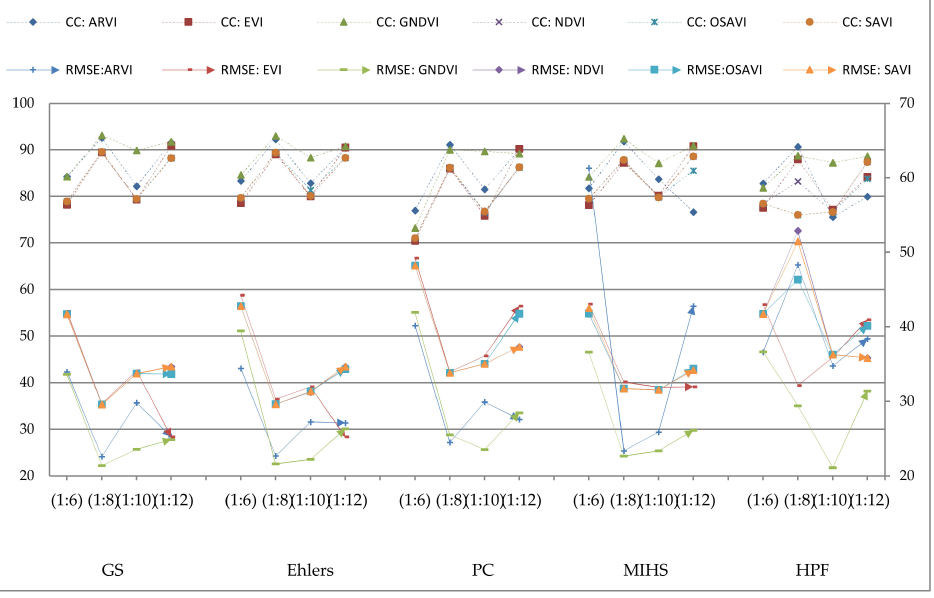
Figure 4. Trend of FVI quality with Image Fusion and SRR(Di ff erent SRF and SNR (Good to Poor)).